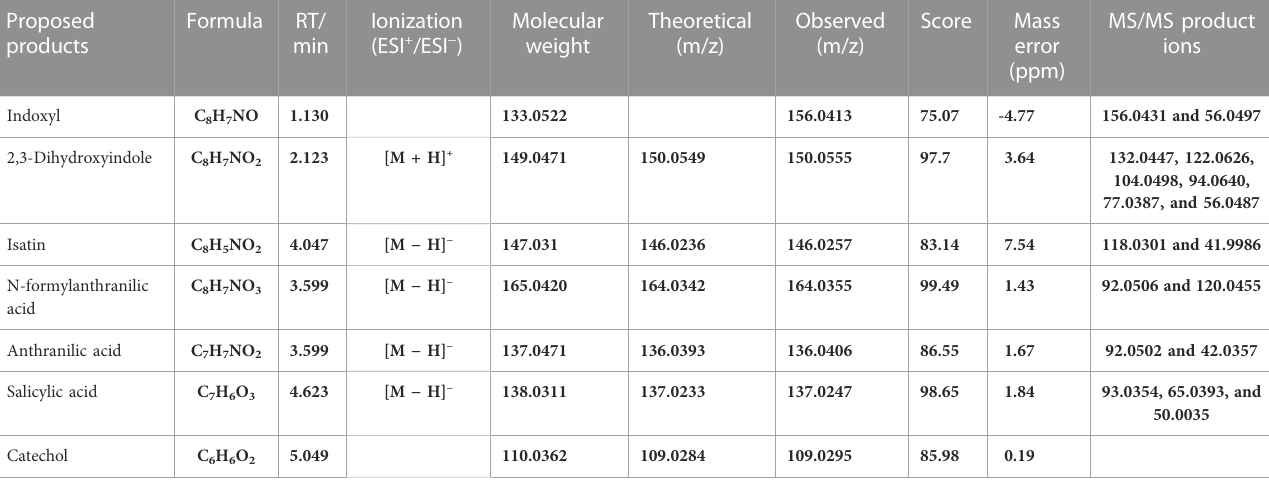
TABLE 4 Results of all product ion scan analyses of biotransformation products related to indole degradation by LC-ESI-QTOF-MS/MS. Proposed products